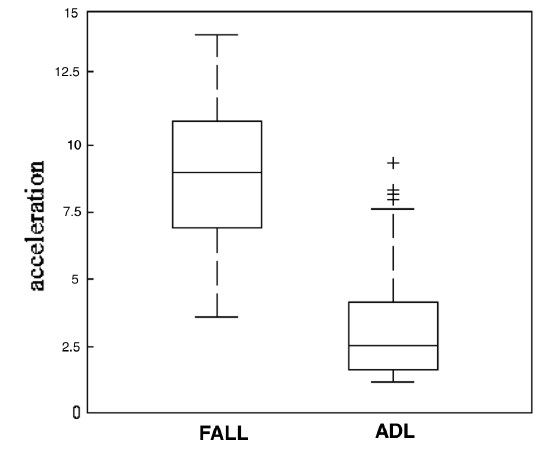
Figure 7. Falls vs. normal activities. Acceleration data